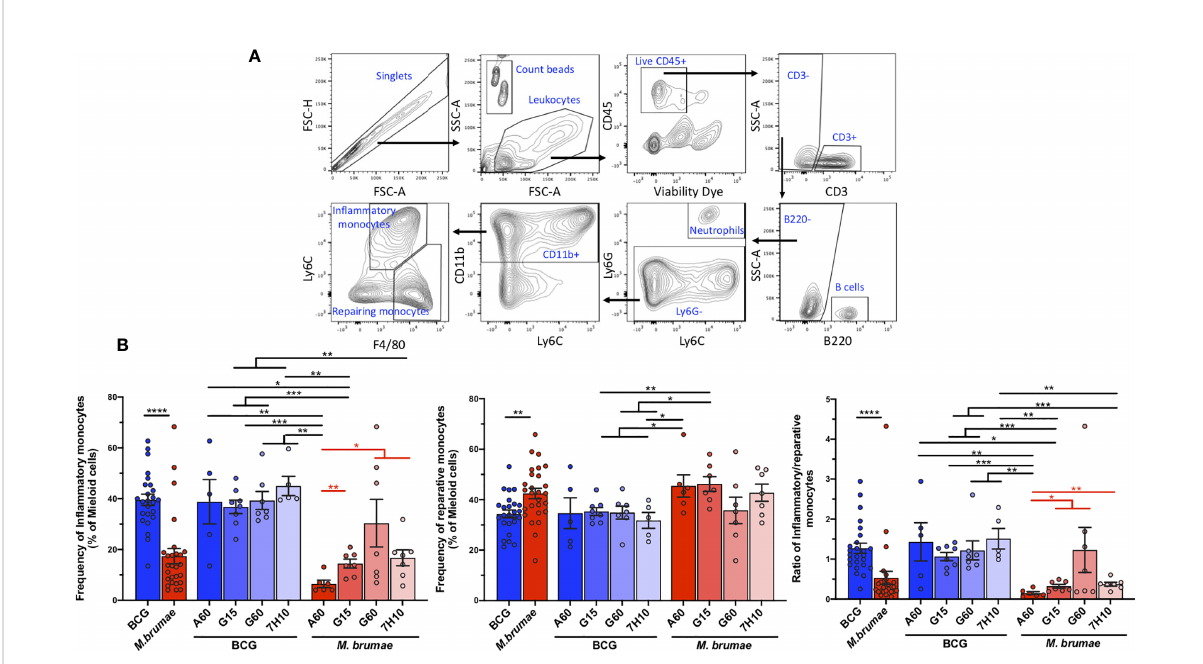
FIGURE 7 M. brumae induce a less in fl ammatory monocyte phenotype than BCG in bladder tumor tissue and can be modulated by culture conditions. (A) FACS gating strategy used to determine in fl ammatory and reparative monocytes. Doublets were excluded, leucocytes were gated by forward and side scatter and live CD45 + tumor in fi ltrating leukocytes were selected. CD3 - cells were gated and the B population (B220 + cells) and the neutrophils (Ly6C + Ly6G + ) were excluded. Myeloid CD11b + were selected and the percentage of in fl ammatory (F4/80 lo/int Ly6C + ) and reparative monocytes (F4/80 int/high Ly6C - ) were obtained. (B) Frequencies of in fl ammatory monocytes and reparative monocytes within total myeloid cells (CD11b + ), and in fl ammatory/reparative ratio from mycobacteria-treated tumor-bearing mice. Data represent the mean (bars) and ± SEM (error bars) and each dot represent a separate mice treated with BCG (blue dots) or M. brumae (red dots). Statistically signi fi cant differences between the different M. brumae mycobacteria are shown as red lines. Interstrain differences are shown in black. Differences were tested using Mann- Whitney U nonparametric test. *p ≤ 0.05; **p ≤ 0.01; ***p ≤ 0.001; ****p ≤